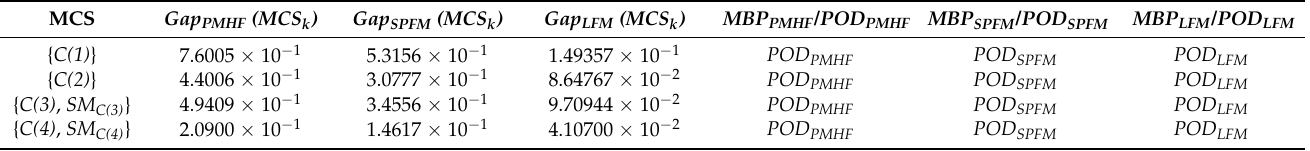
and DC DPF , L in the design iteration 4–6. (The DC value adjusted PT ( e ) PT ( e )